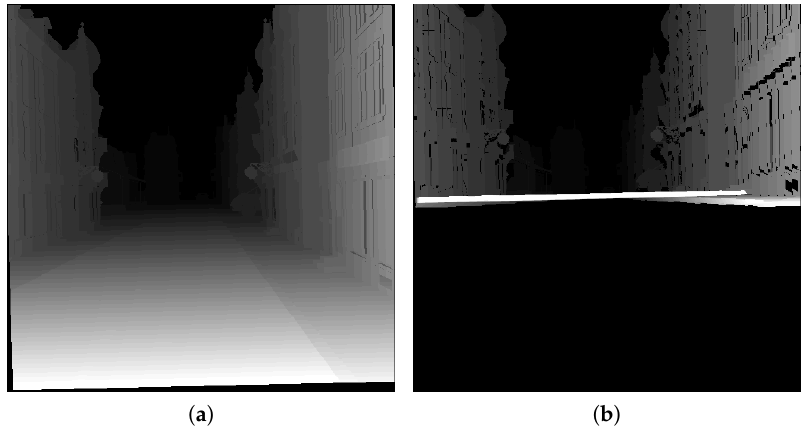
Figure 11. ( a ) Original disparity map (equalized); ( b ) virtual disparity map (equalized).